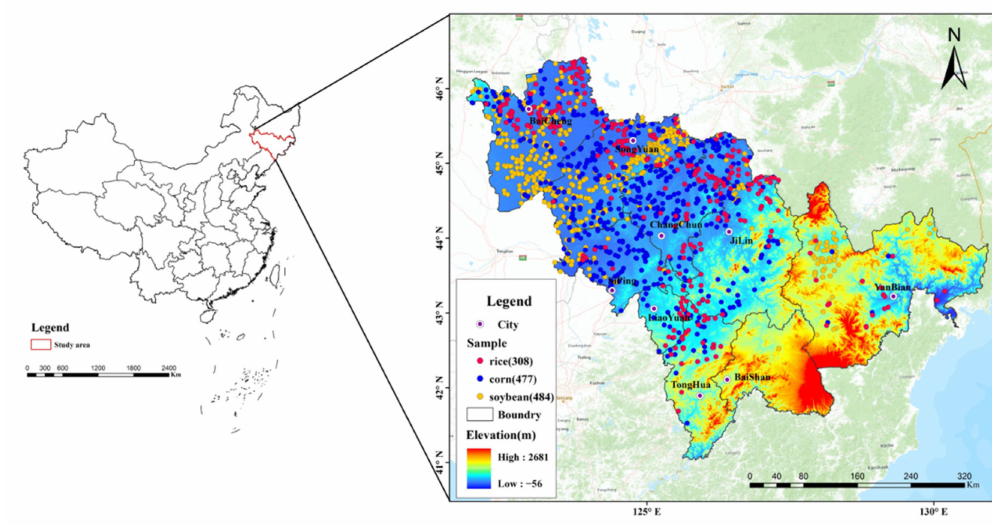
Figure 1. Location map of the study area.